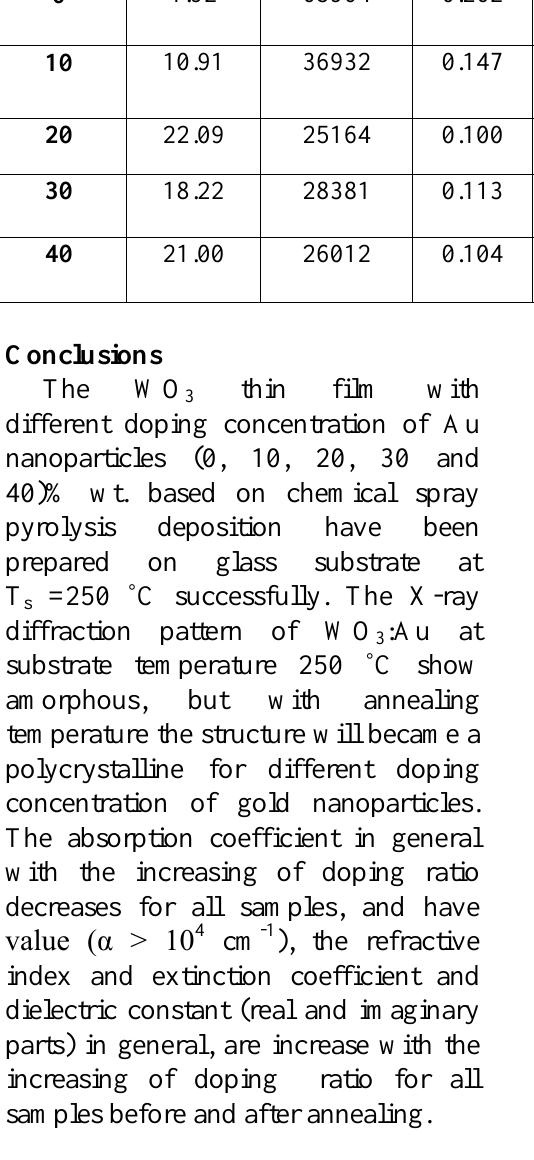
Table 5: The optical energy gap and the optical constants parameters for pure WO different doping of Au thin films at T